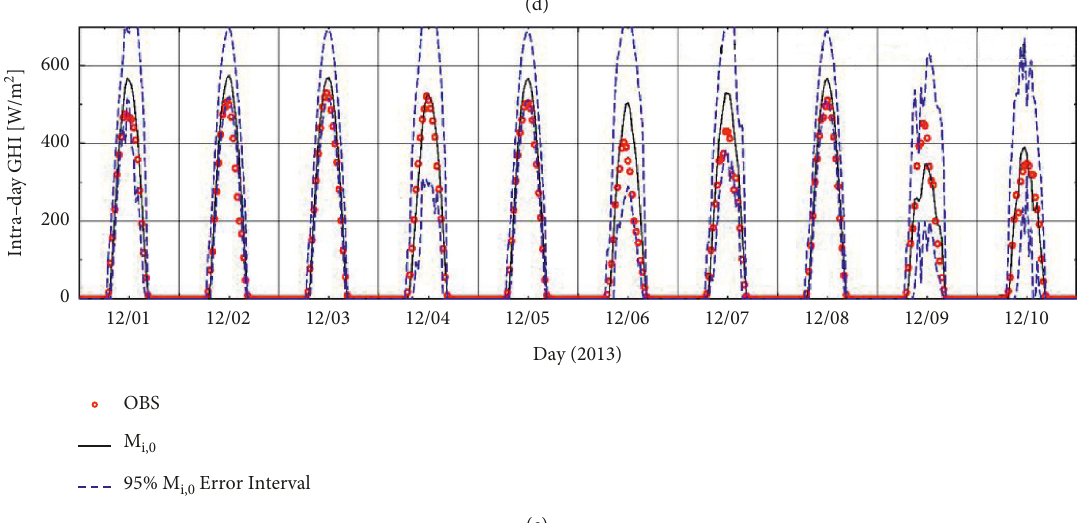
Figure 9: Time series of solar GHI intraday prediction by using model WRF only M the period from December 1 to 10 in 2013. (a) M i, prediction and 80% prediction interval, (d) M i,